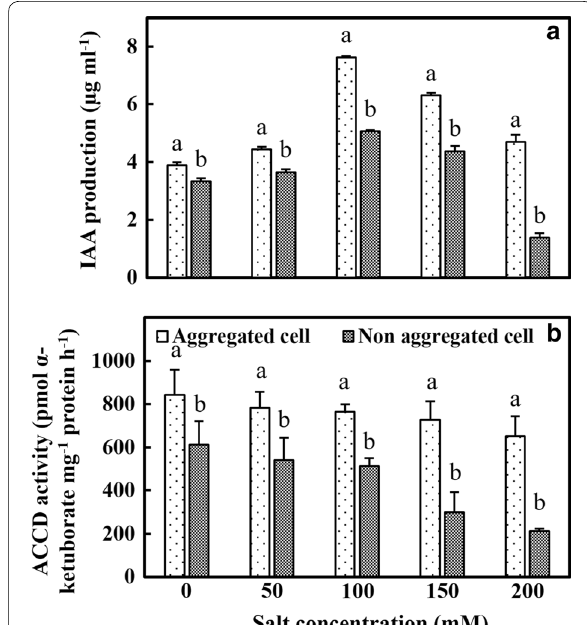
Fig. 4 The impact of different salt concentration on production of plant growth promoting traits of M. oryzae CBMB20 cells. a IAA pro- duction. b ACC deaminase production. All data represents mean SE ± of three replicates and differences between means analyzed using DMRT test ( P 0.05) All data represents mean SE of three replicates ≤ ± and differences between means analyzed using DMRT test ( P ≤